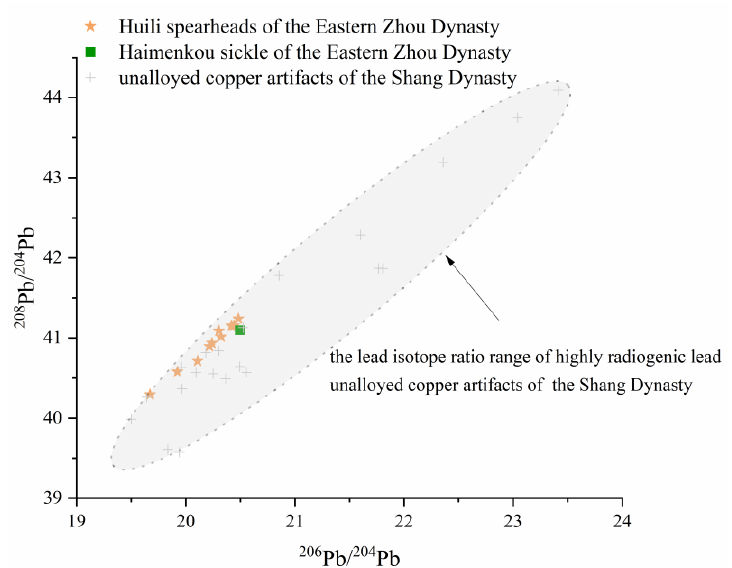
Figure 4. Lead isotope ratios of the highly radiogenic lead copper artifacts in the Eastern Zhou Dynasty and the Shang Dynasty (the range of the highly radiogenic lead of Shang copper artifacts was drawn based on the analyzed data, and the related information is summarized in Supplementary information, Table